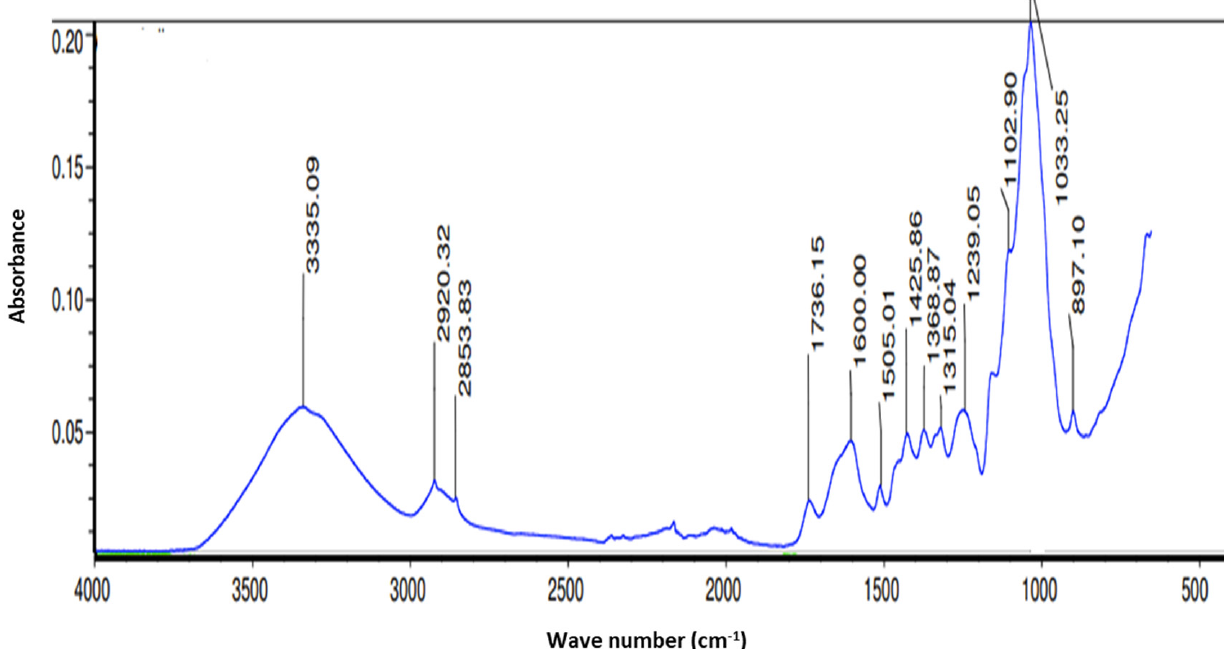
Figure 4. FTIR spectogram of flax shives coproducts.